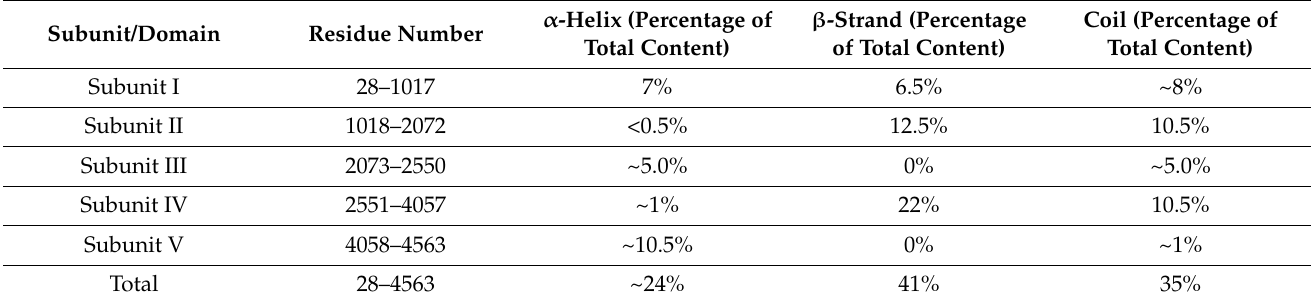
Table 4. Subunits prediction and secondary structure